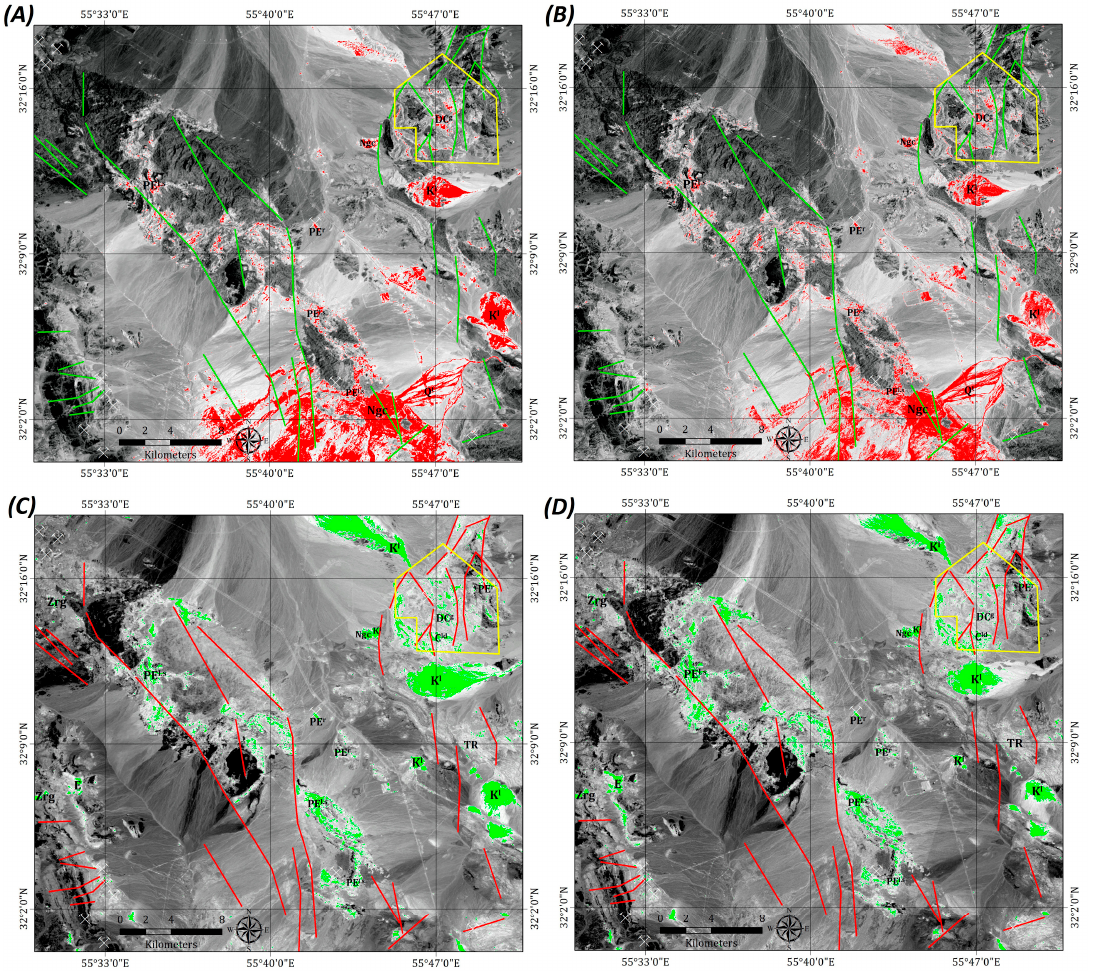
Figure 6. Band ratio image-maps showing spatial distribution of iron oxide / hydroxides and clay and carbonate minerals. ( A ) The 4 / 2 band ratio image-map of Landsat-8 showing iron oxide / hydroxides minerals as red pixels; ( B ) the 4 / 2 band ratio image-map of Sentinel-2 showing iron oxide / hydroxides minerals as red pixels; ( C ) the 6 / 7 band ratio image-map of Landsat-8 showing clay minerals and carbonates as green pixels; ( D ) the 11 / 12 band ratio image-map of Sentinel-2 showing hydroxyl-bearing minerals as green pixels. Yellow polygon demarcates WV-3 imagery. The 4/2 band ratio of ASTER shows the iron oxide/hydroxide minerals in red pixels, which are typically mapped in the PE 1.s unit, the K 1 unit, the PE r unit, the DCg unit, the PE Ed unit, the Kuhbanan